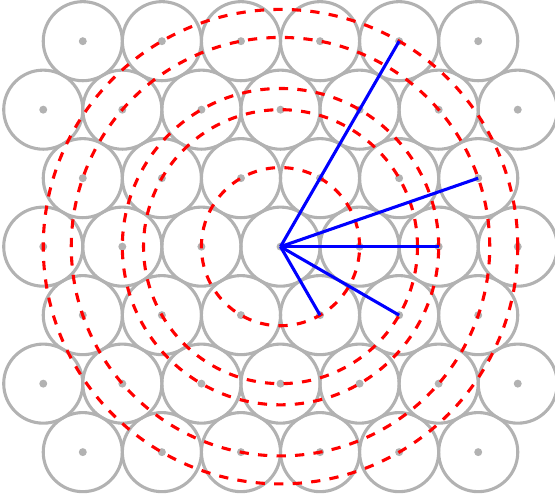
Figure 11. Epipolar lines in a hexagonally arranged MLA. Due to the reason that the micro images are rectified to each other by na- ture, the epipolar line for a pair of micro images is defined by the vector between the respective principal points. The figure exemplar- ily shows one epipolar line (blue) for the five shortest stereo baseline distances